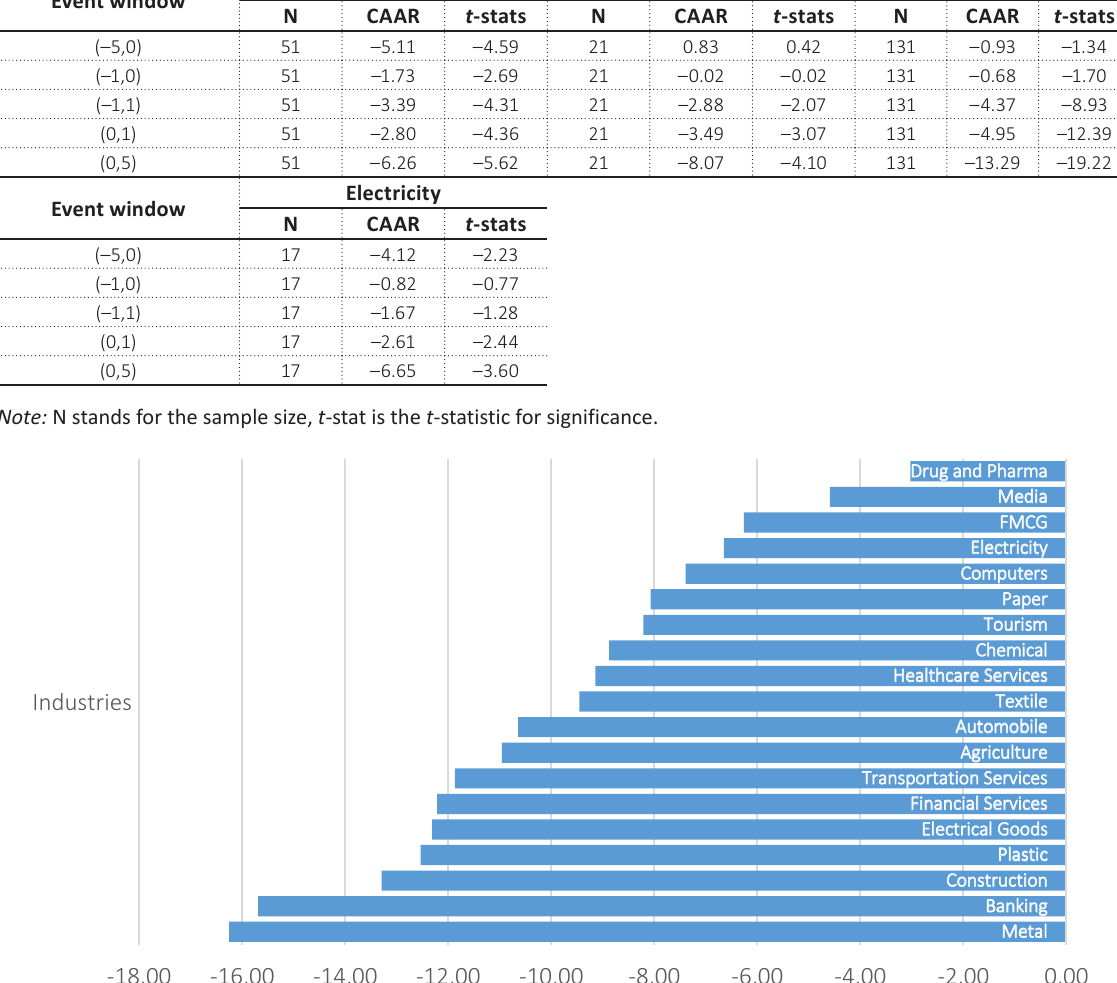
Table 6. CAAR for the FMCG, paper, construction, and electricity sectors to show the impact of the COVID-19 outbreak in different event windows FMCG Paper Event window